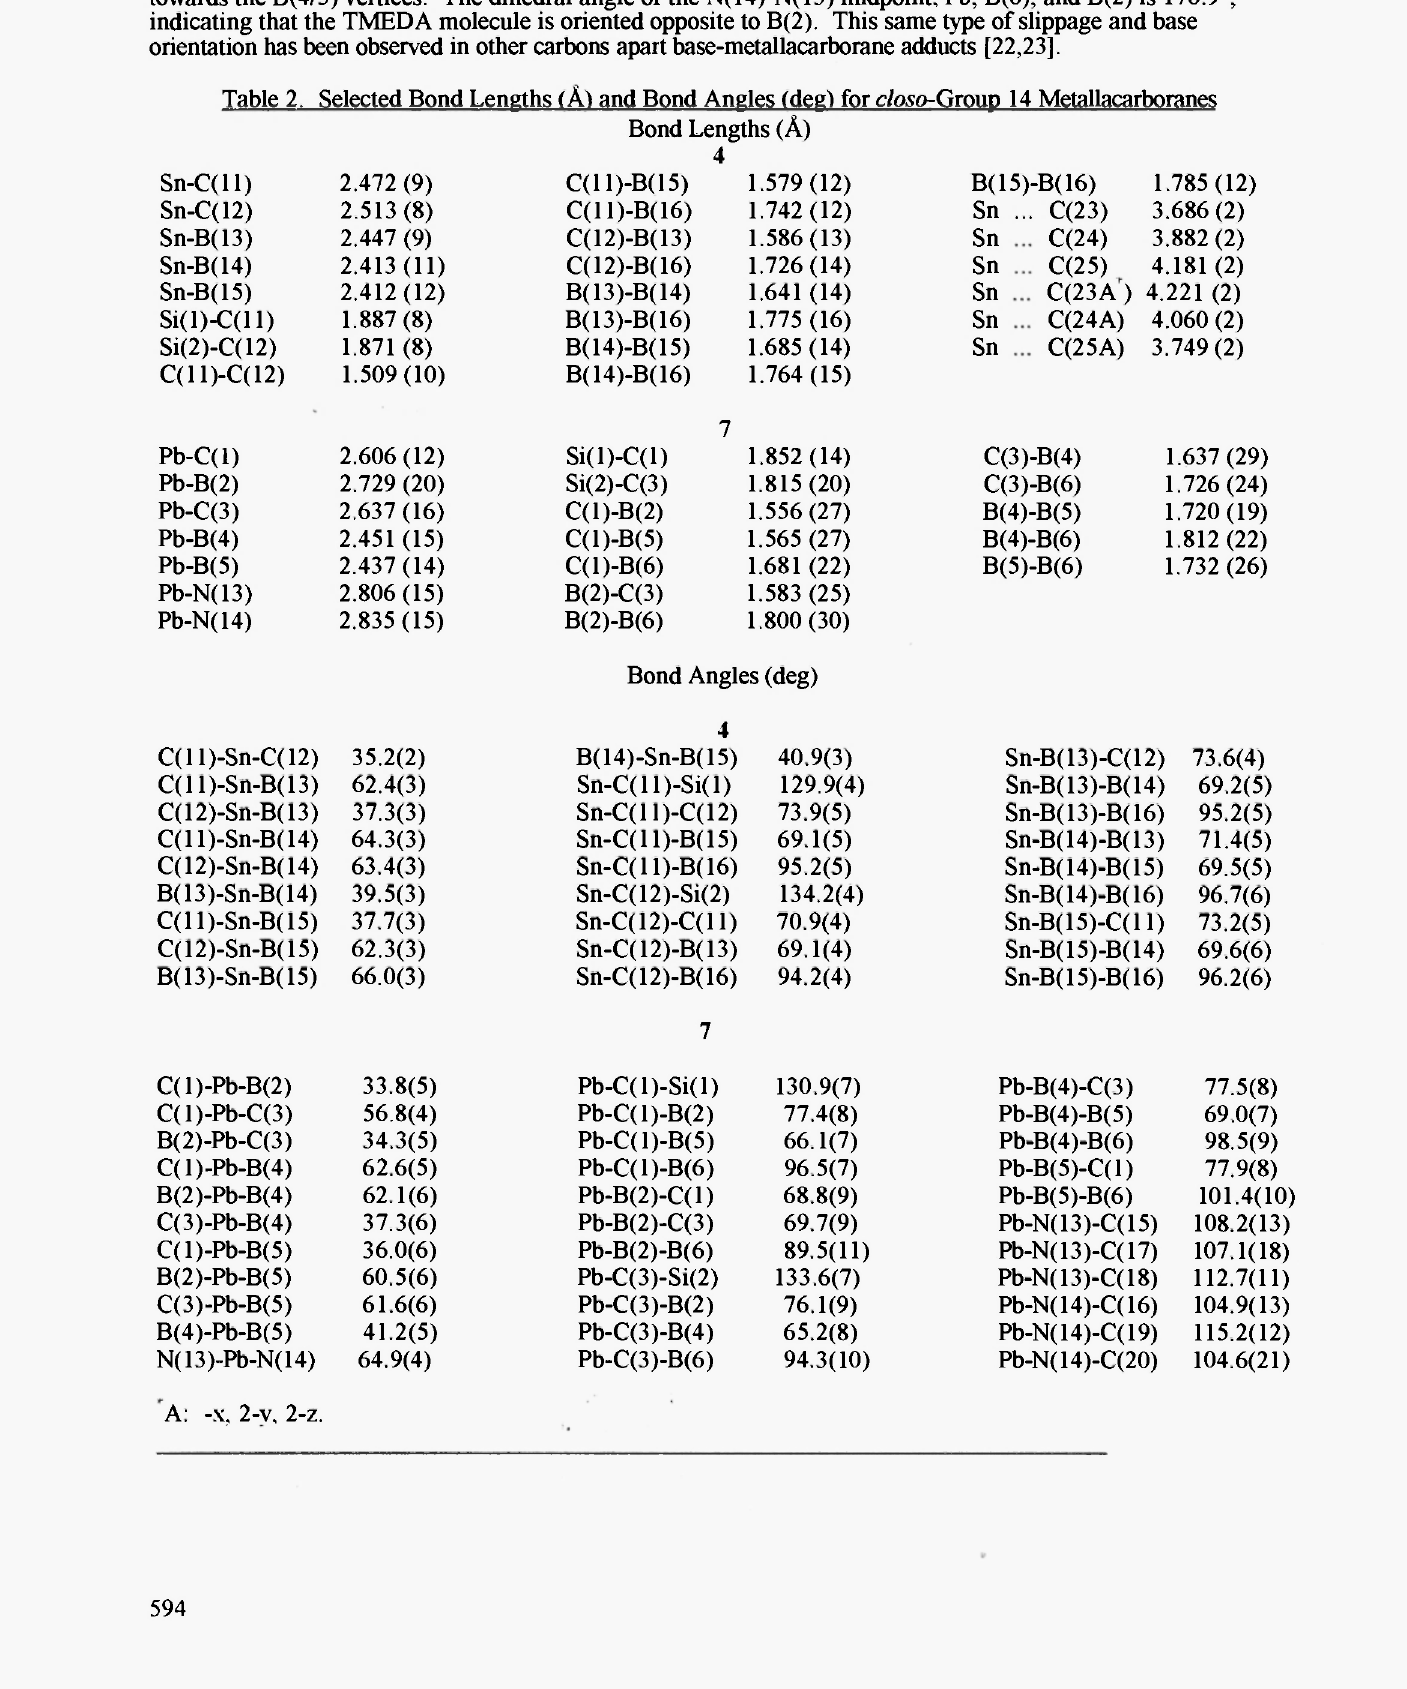
Table 2. Selected Bond Lengths (A) and Bond Angles (deg) for c/oso-Group 14 Metallacarboranes Bond Lengths